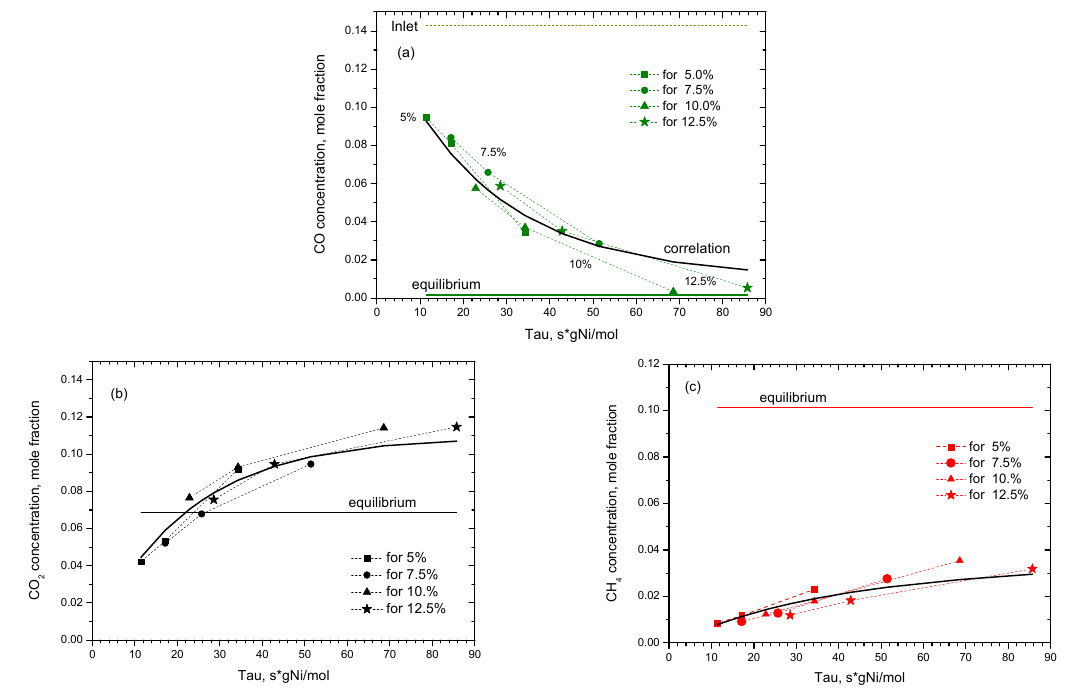
Figure 14. Correlation curves (thick black lines) between CO ( a ), CO 2 ( b ), and CH 4 ( c ) concentrations